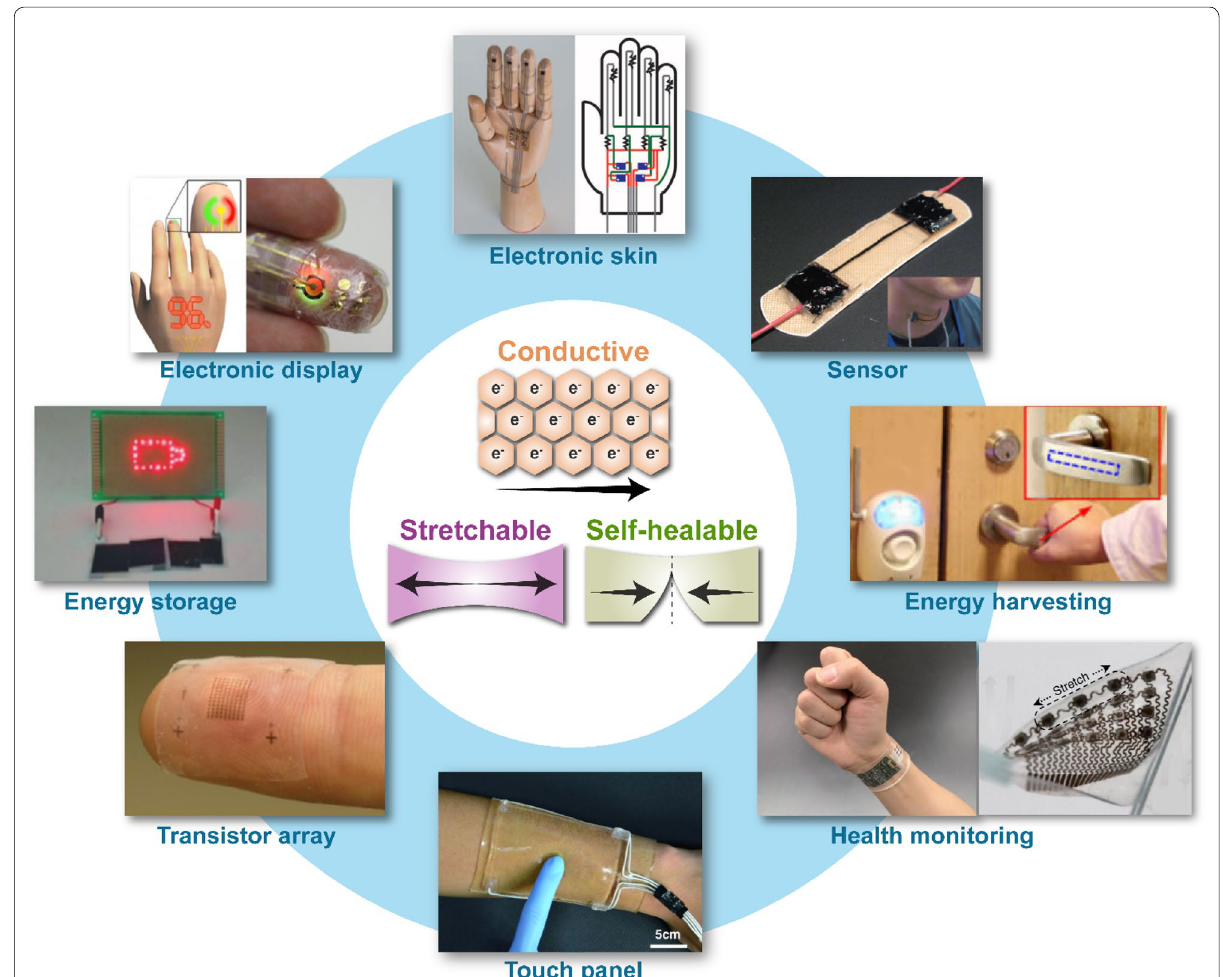
Fig. 1 Illustration and potential applications of stretchable and self-healable conductors. Figures sequence is from top and clockwise. Illustrated figure of an electronic skin. Reproduced with permission [15]. Copyright 2015, American Association for the Advancement of Science. Photograph of a stretchable strain sensor. Reproduced with permission [17]. Copyright 2011, Nature Publishing Group. Photograph of an energy harvesting device. Reproduced with permission [18]. Copyright 2014, American Chemical Society. Photograph (left) of a health monitoring wearable sensor array. Reproduced with permission [21]. Copyright 2016, Nature Publishing Group. Photograph (right) of a stretchable ultrasonic device for blood pressure waveform monitoring. Reproduced with permission [22]. Copyright 2018, Nature Publishing Group. Illustrated figure of a highly stretchable and transparent ionic touch panel. Reproduced with permission [23]. Copyright 2016, American Association for the Advancement of Science. Photograph of a stretchable transistor array on fingertip [19]. Reproduced with permission. Copyright 2018, Macmillan Publishers Limited. Photograph of healed zinc ion battery. Reproduced with permission [24]. Copyright 2019, Wiley–VCH. Photograph of an electronic display. Reproduced with permission [20]. Copyright 2016, American Association for the Advancement of